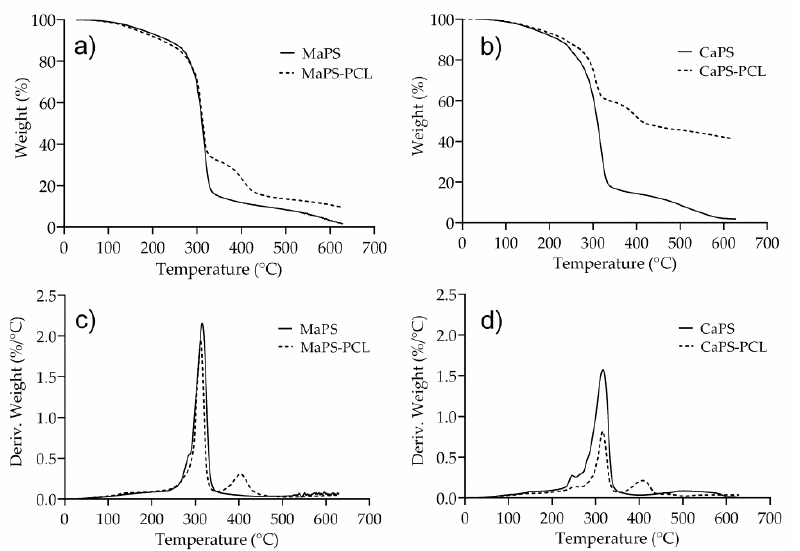
Figure 4. TGA traces of ( a ) MaPS and MaPS–PCL and ( b ) CaPS and CaPS–PCL. DTG traces of ( c ) MaPS and MaPS–PCL and ( d ) CaPS and CaPS–PCL.